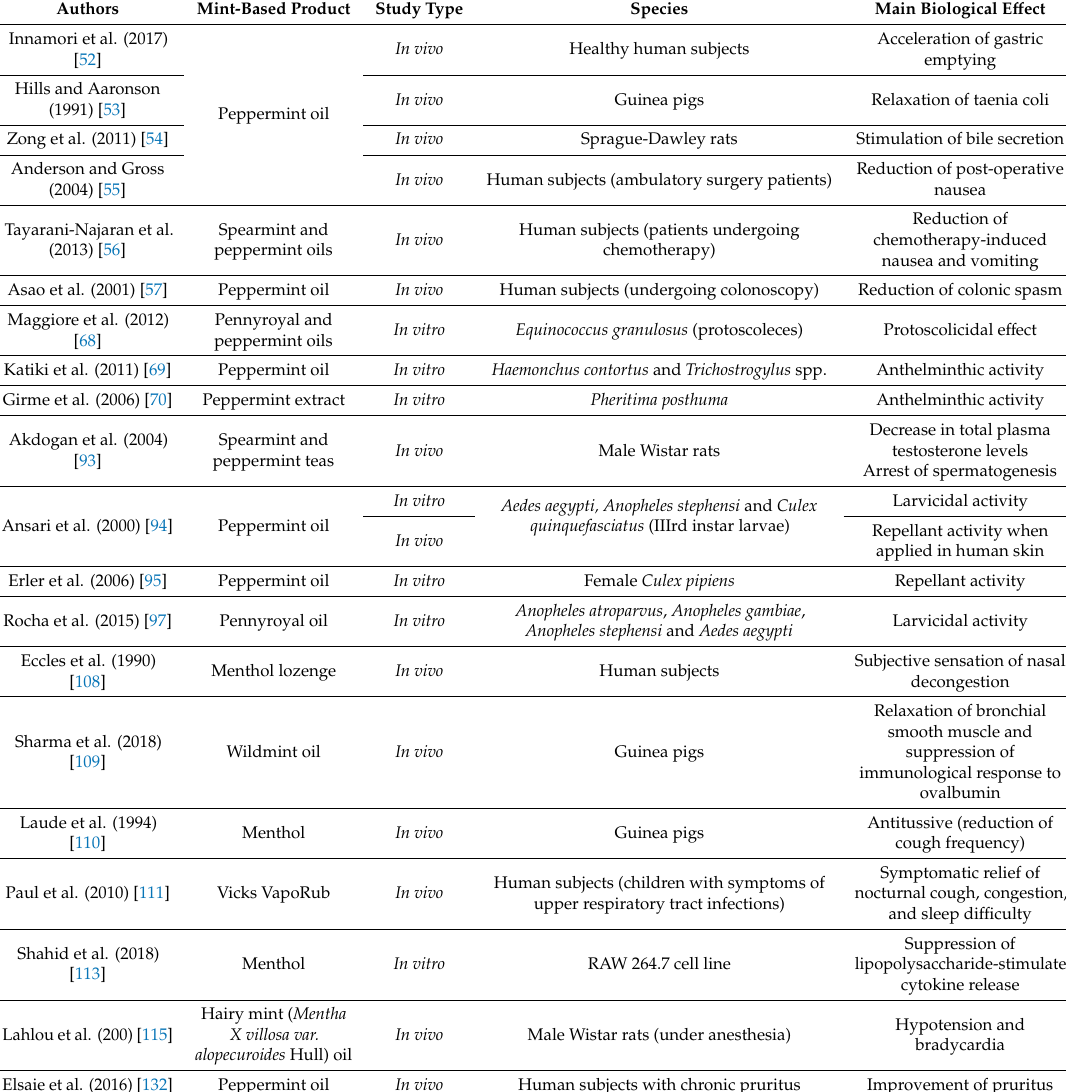
Table 2. Description and main results of relevant studies assessing the health-promoting e ff ects of mint-based